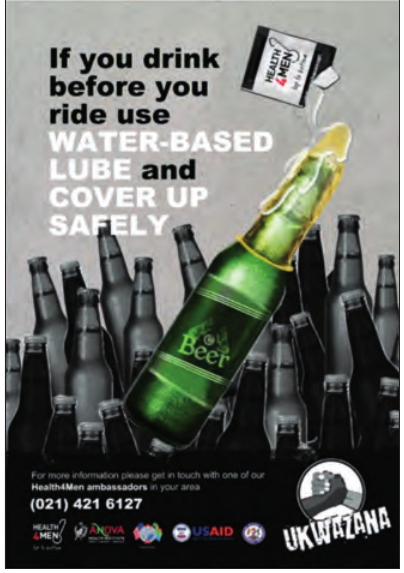
Fig. 1. The Ukwazana (getting to know each other) campaign. An example of HIV risk- reduction messaging designed to reach MSM though township taverns/shebeens where MSM congregate.